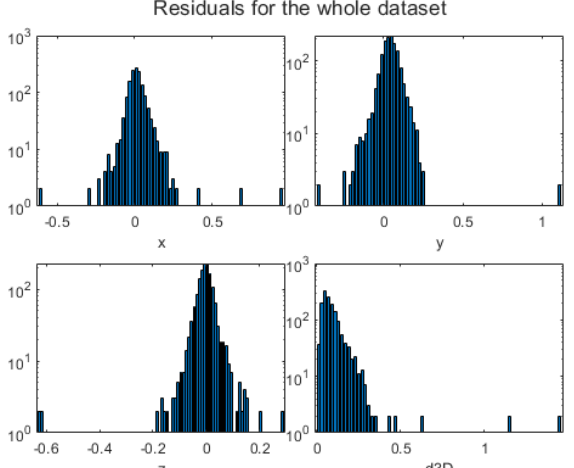
Figure 9. Histograms of the residuals of the whole dataset (all the users, all the points, all the distances); y scale is logarithmic, in order to make low-populated bins